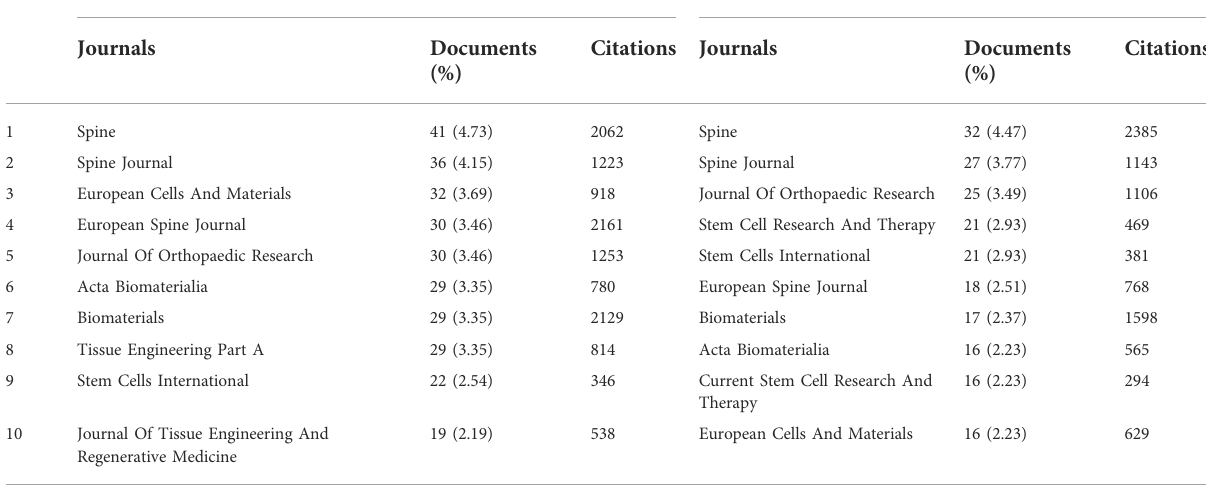
TABLE 3 Top 10 Journals contributing to Publications in the WOSCC and Scoups database.